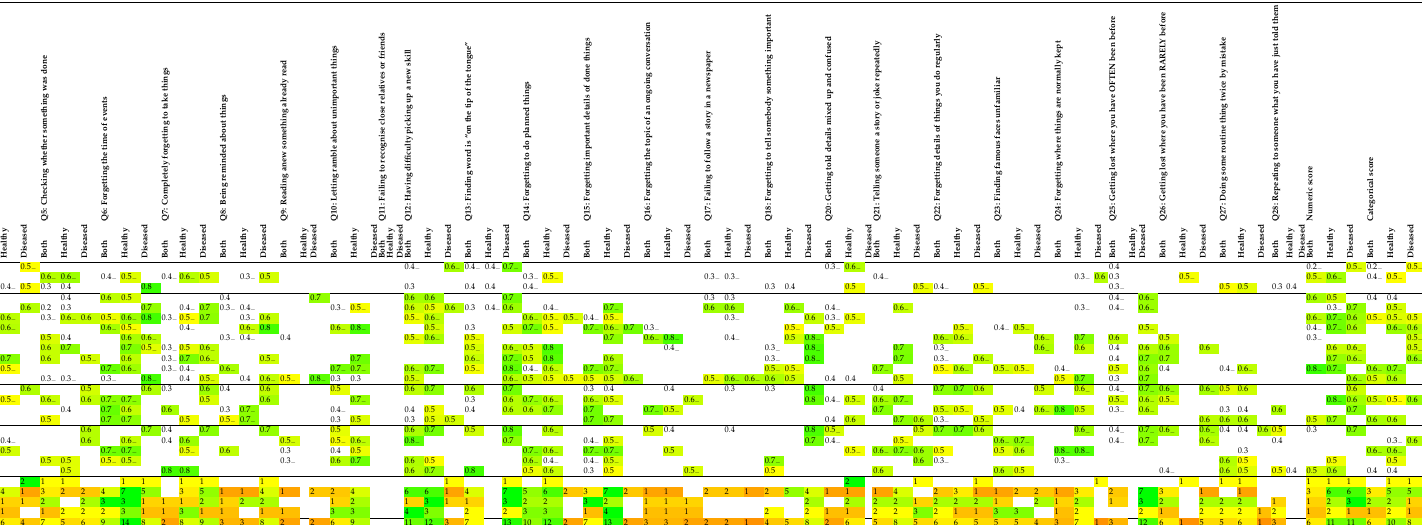
Color coding: from orange (weaker correlation/fewer total correlations) to yellow to green (stronger correlation/more total correlations). Only significant correlations are shown. Only coefficients of 0.5 or above are